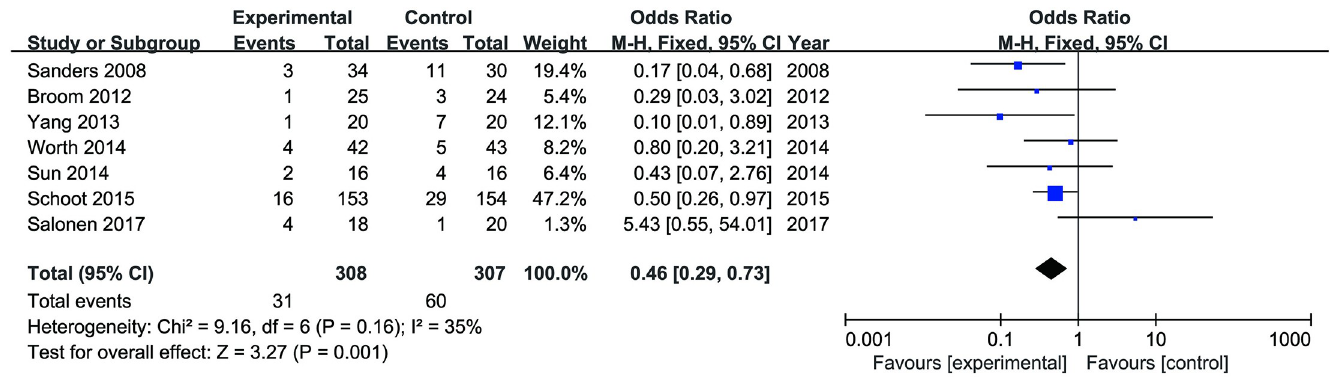
Fig 3. CRBSI per patient for trials that compared ethanol locks with heparin.